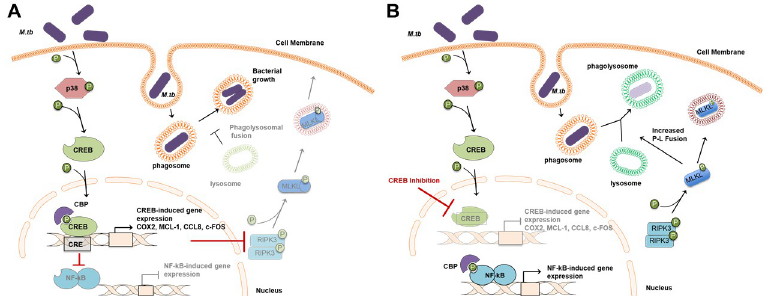
Fig 11. Model. In human macrophages, M . tb infection induces phosphorylation of p38 MAPK resulting in downstream phosphorylation of the transcription factor CREB. A) Phosphorylated CREB enters the nucleus and forms a transcriptional complex binding coactivator CREB binding protein (CBP), corresponding with decreased nuclear colocalization of NF-kB, which also requires CBP [10]. Activated CREB transcribes M . tb -induced genes including early expression of COX2, MCL-1, CCL8 and c-FOS. CREB also prevents phosphorylation of RIPK3 and MLKL (red blocking arrow) limiting pMLKL-dependent lysosomal fusion with the M . tb -containing phagosome, all things that contribute to intramacrophage bacterial growth. B) When CREB binding to CBP is inhibited with 666–15 constraining CREB signaling (red blocking arrow), less CREB is localized to the nucleus. In contrast, NF-kB nuclear localization is increased during CREB inhibition. It is possible that CBP is now available to bind NF-kB, likely leading to increased transcription of NF-kB regulated gene expression. CREB inhibition also leads to increased phosphorylation of